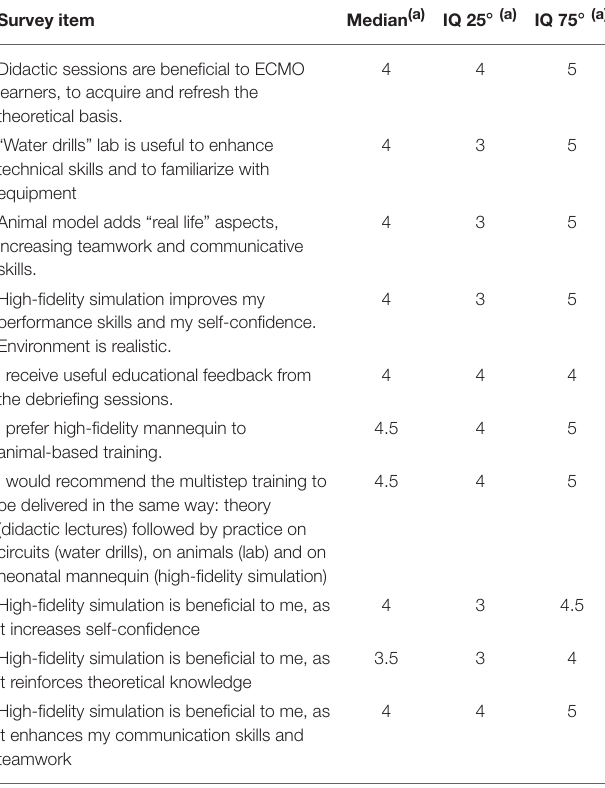
TABLE 4 | ECMO “curriculum” evaluation. Survey